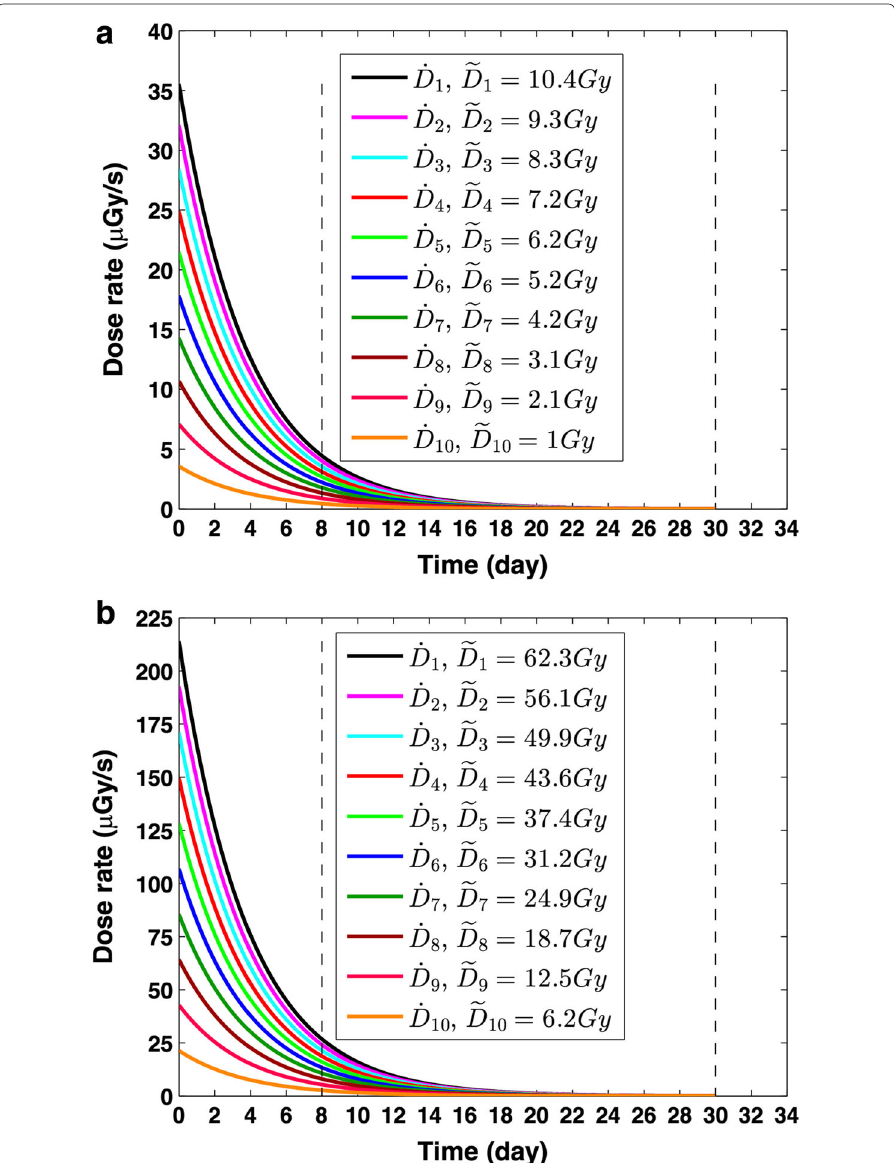
Fig. 5 Dose rate ( ˙ D ) and corresponding total dose ( D ) for different 90 YCl 3 concentrations calculated for T = 8 days: a LDR– 90 Y and b HDR– 90